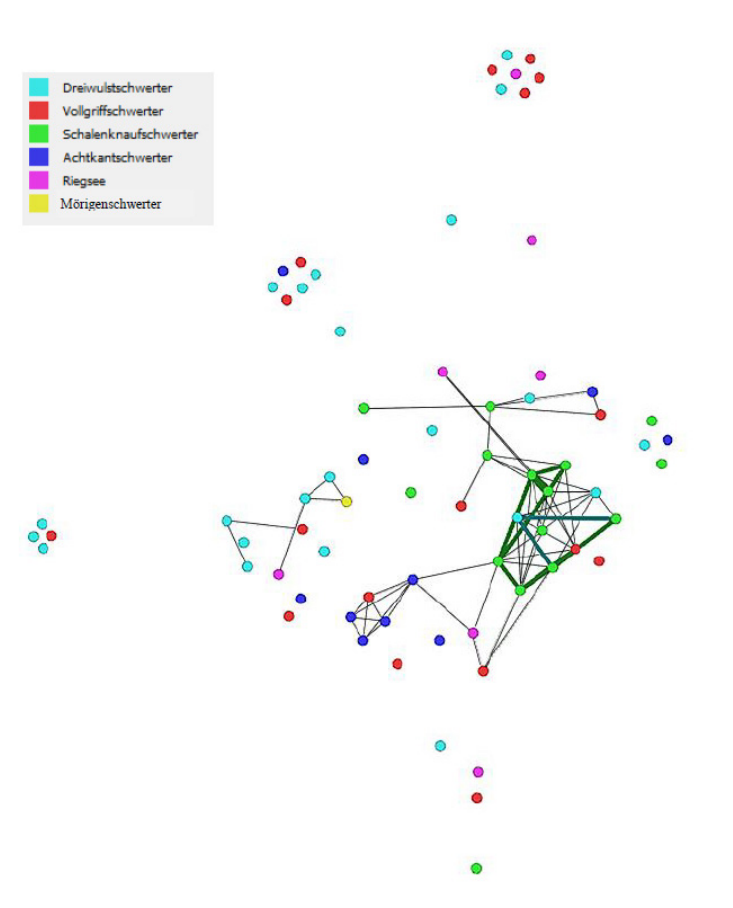
Figure 10. Force atlas projection of individual blades connected by shared decorative data